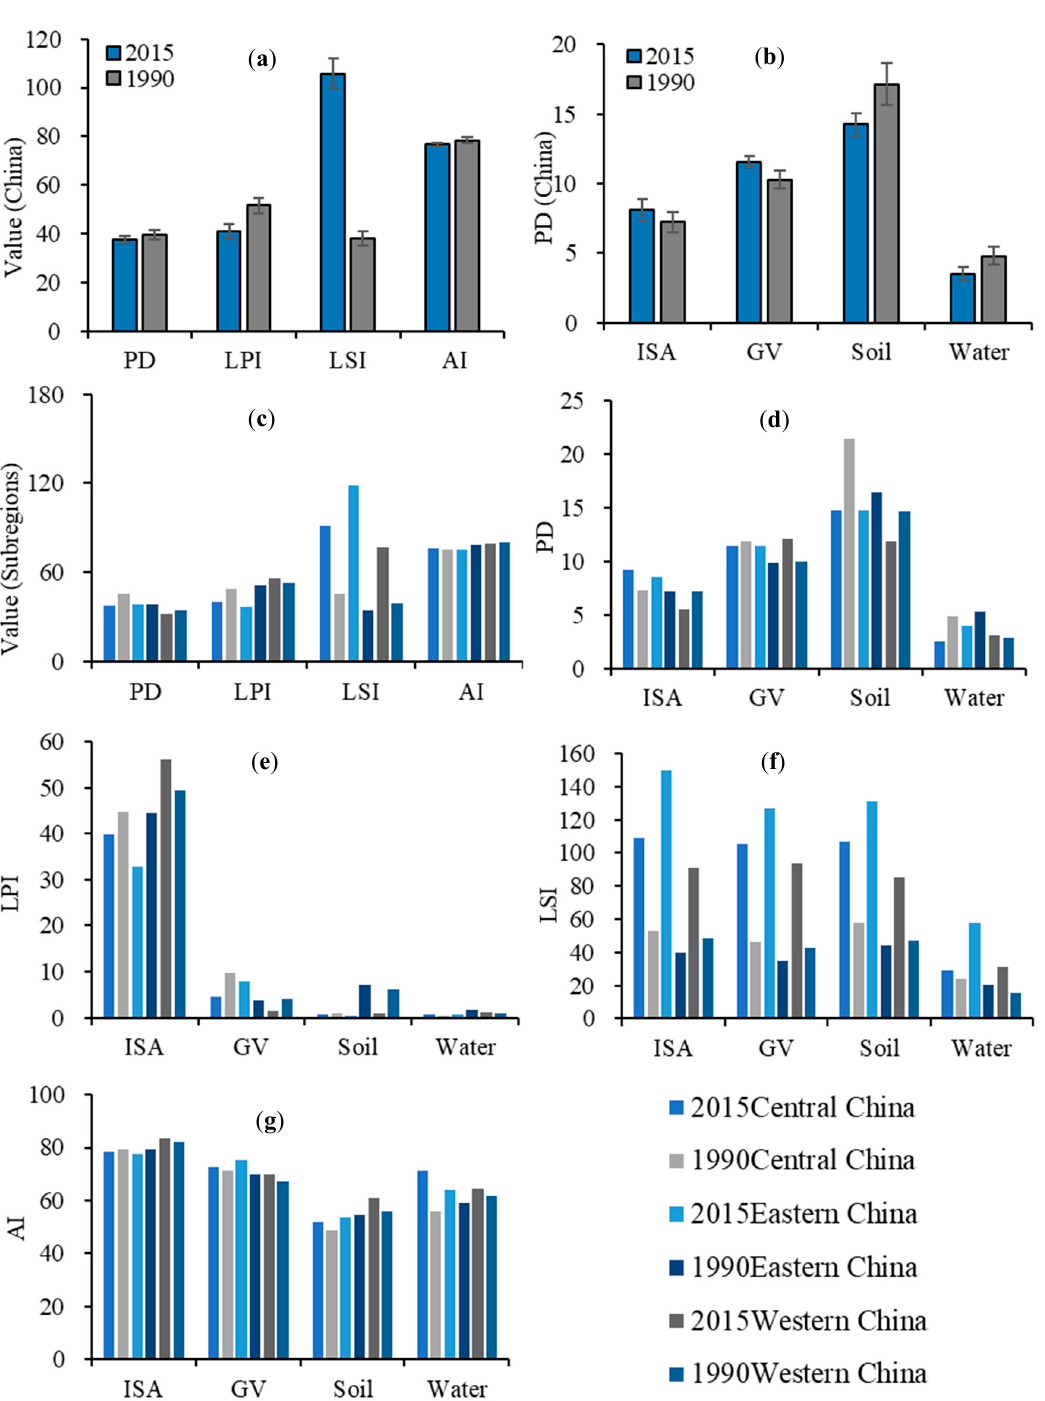
Figure 5. Changes in the landscape indexes from 1990 to 2015. ( a ) Changes in landscape patterns at the national scale. ( b ) Patch density (PD) changes in land-cover types at the national scale. ( c ) Changes in landscape patterns at the subregional scale. ( d ) PD changes in land-cover types at the subregional scale. ( e ) Largest patch index (LPI) changes in land-cover types at the subregional scale. ( f ) Landscape shape index (LSI) changes in land-cover types at the subregional scale. ( g ) Aggregation index (AI) changes in land-cover types at the subregional scale.